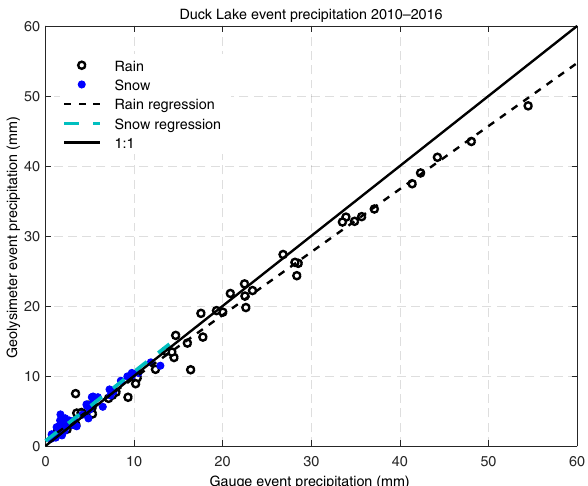
Figure 3. Duck Lake geolysimeter event precipitation compared with gauge event precipitation separated into rain and snow. Re- gression lines for rain and snow and the 1:1 line are also